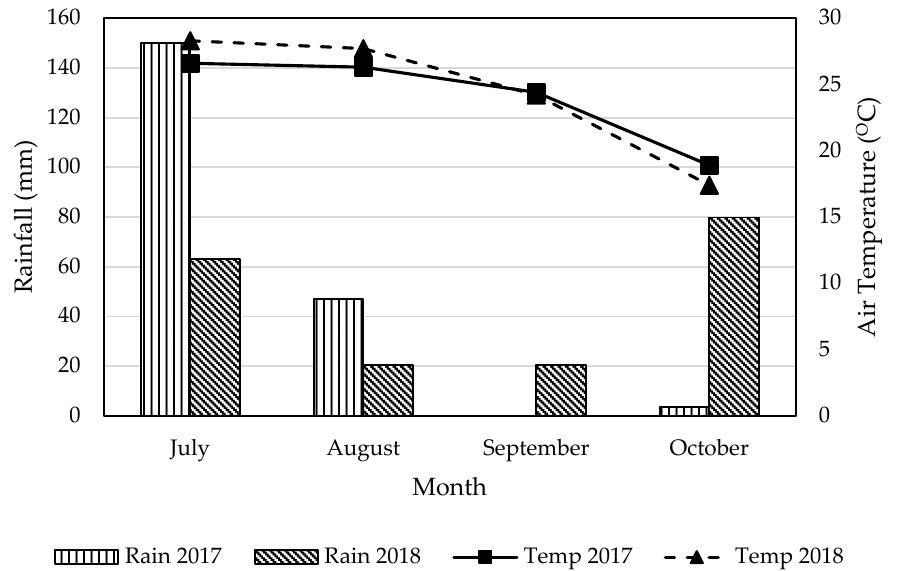
Figure 1. Monthly mean air temperature ( ◦ C) (lines) and rainfall (cm) (bars) in 2017 and 2018 recorded at Leyendecker Plant Science Center.